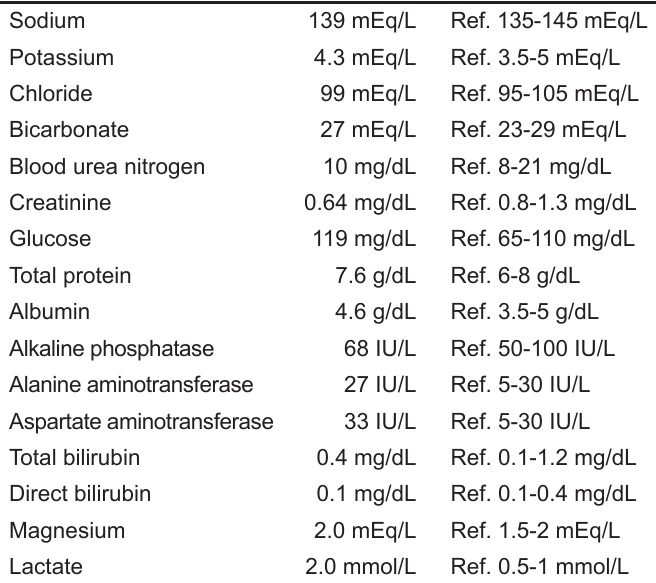
Table 2. Serum chemistry results